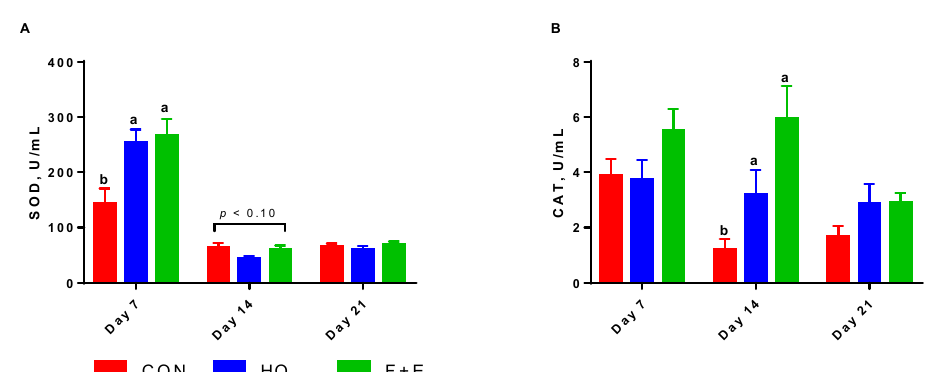
Figure 2. The activities of superoxide dismutase and catalase in milk supernatants of lactating sows: ( A ) The activity of SOD in milk supernatant; ( B ) The activity of CAT in milk supernatant. The results are presented as mean and SEM. The bars with different small letters mean a significant difference ( p < 0.05) at the same time point, and p < 0.10 means a tendency. CON = control; HQ = high quality; F + E = flavor plus multi-enzymes; SOD = superoxide dismutase; CAT = catalase.